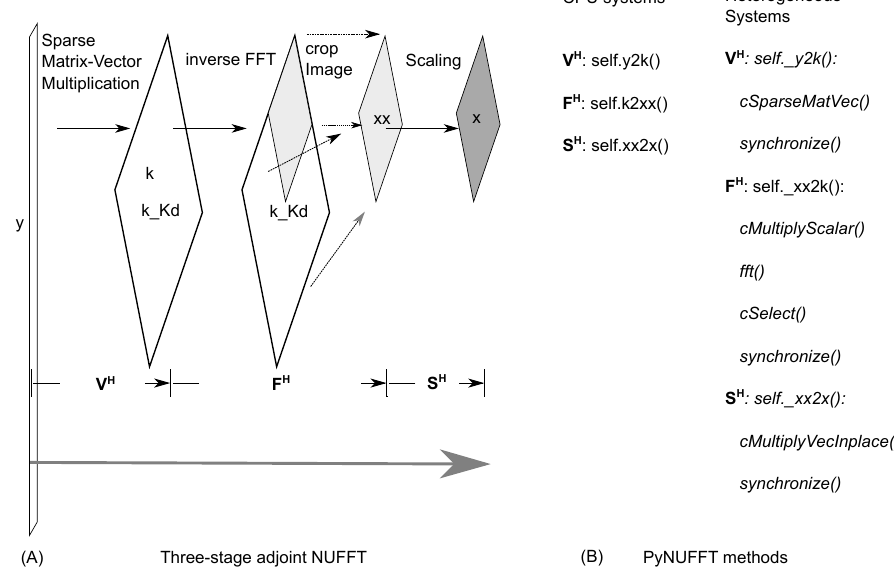
Figure 4. ( A ) The adjoint PyNUFFT; ( B ) The methods provided in PyNUFFT. Adjoint NUFFT can be decomposed into three stages: gridding, inverse FFT (IFFT), and rescaling.